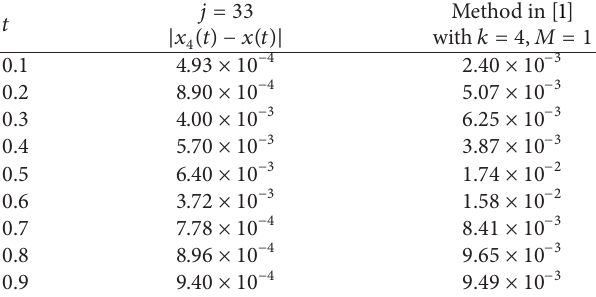
Table 1: Absolute errors for Example 1.